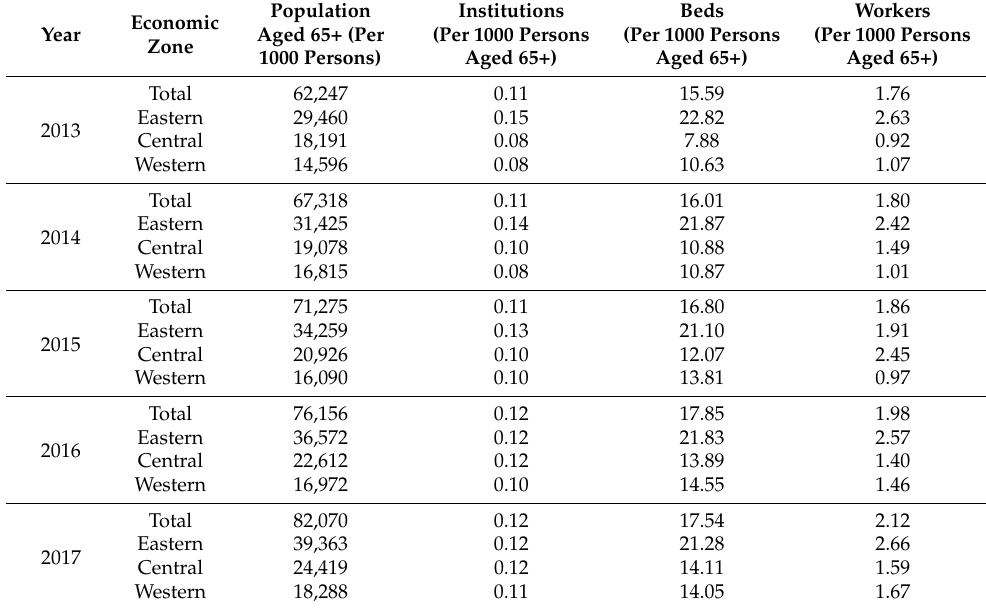
Table 2. LTC resource distribution in urban areas (2013–2017).